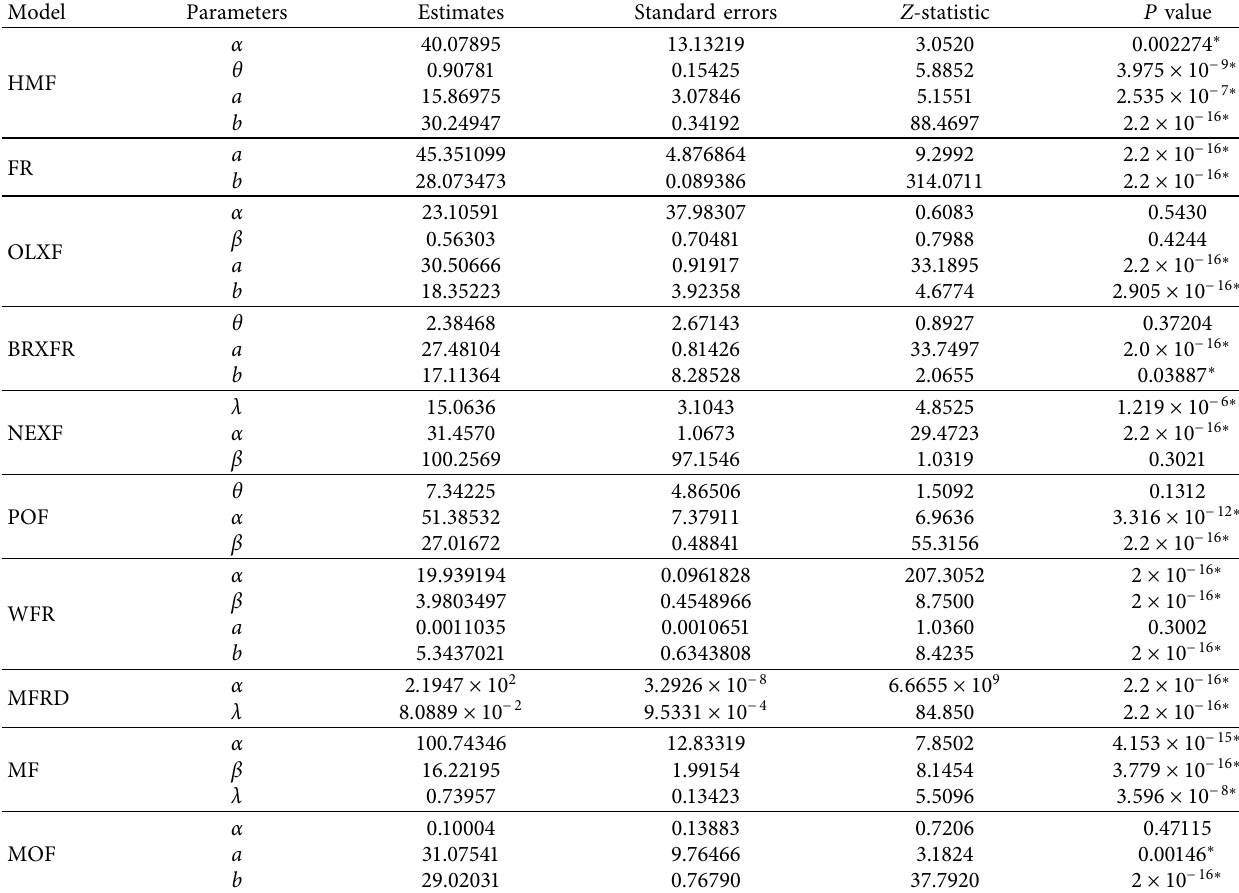
Table 7: MLEs for annual maximum temperature dataset.